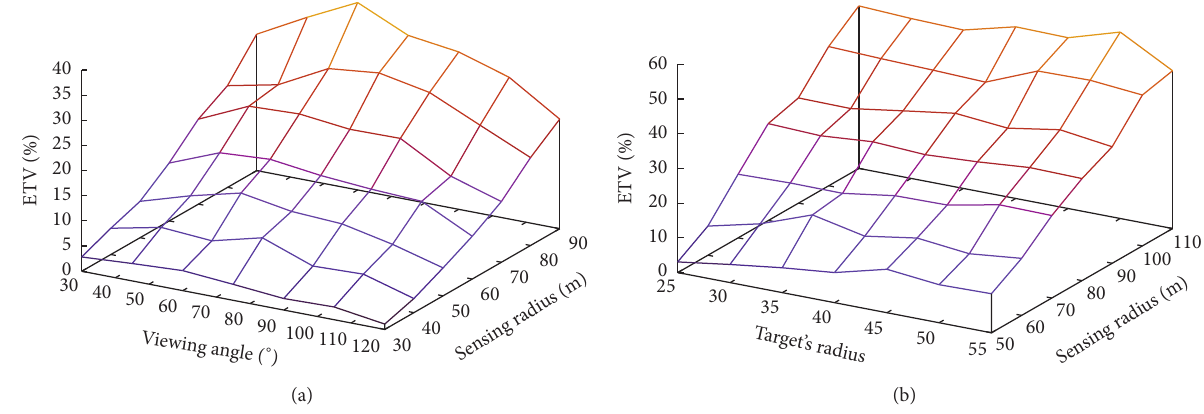
Figure 9: ETV for large targets: (a) 20 targets with 𝑅 (𝑡) = 50 ; (b) 5 targets with 𝑅 (𝑡) = 50